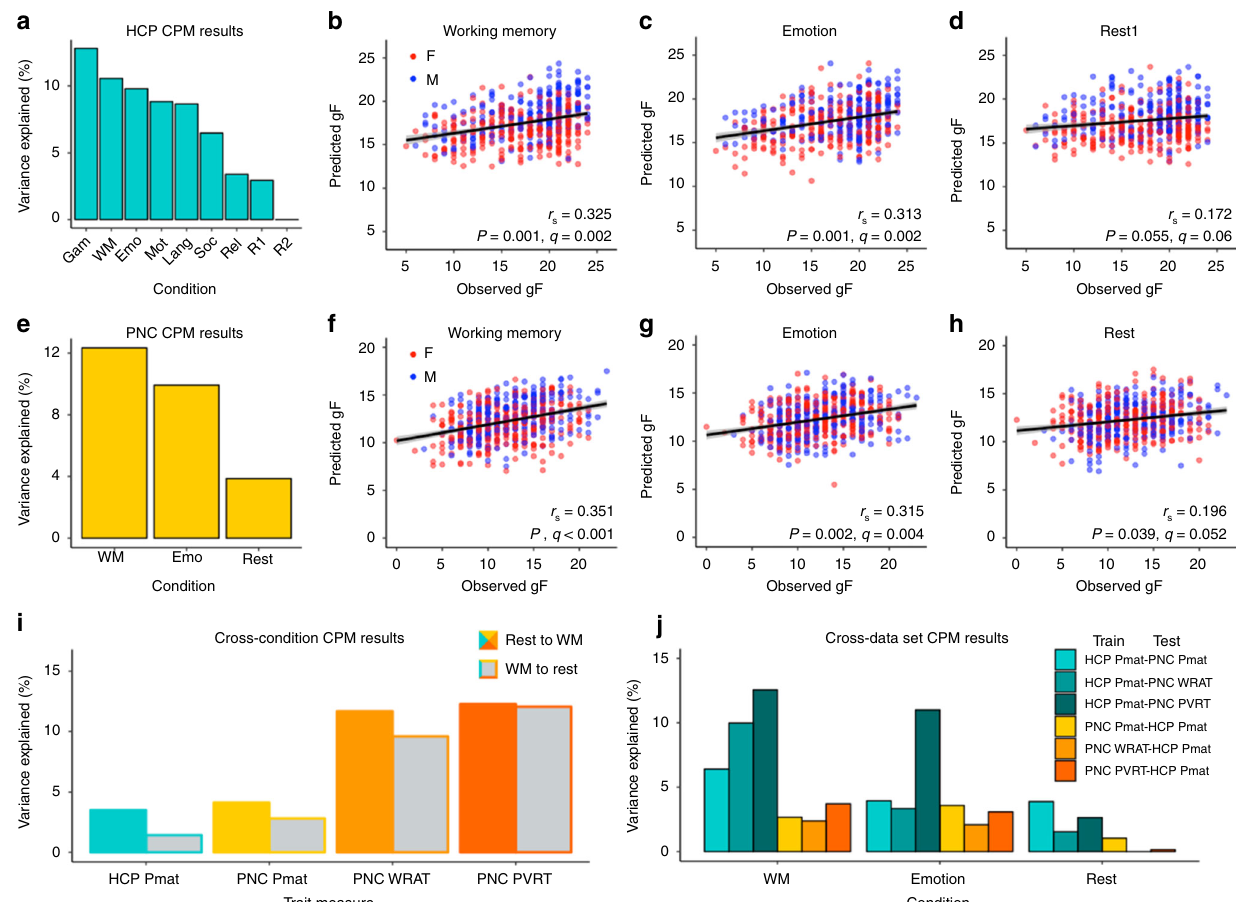
Fig. 1 Task-induced brain state is a key determinant of individual trait prediction accuracy. a Results from the cross-validated CPM pipeline in each of the 9